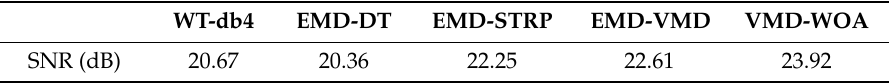
Table 2. The SNRs of the geometric overlap factor (GOF)-corrected signal processed by the different denoising techniques.